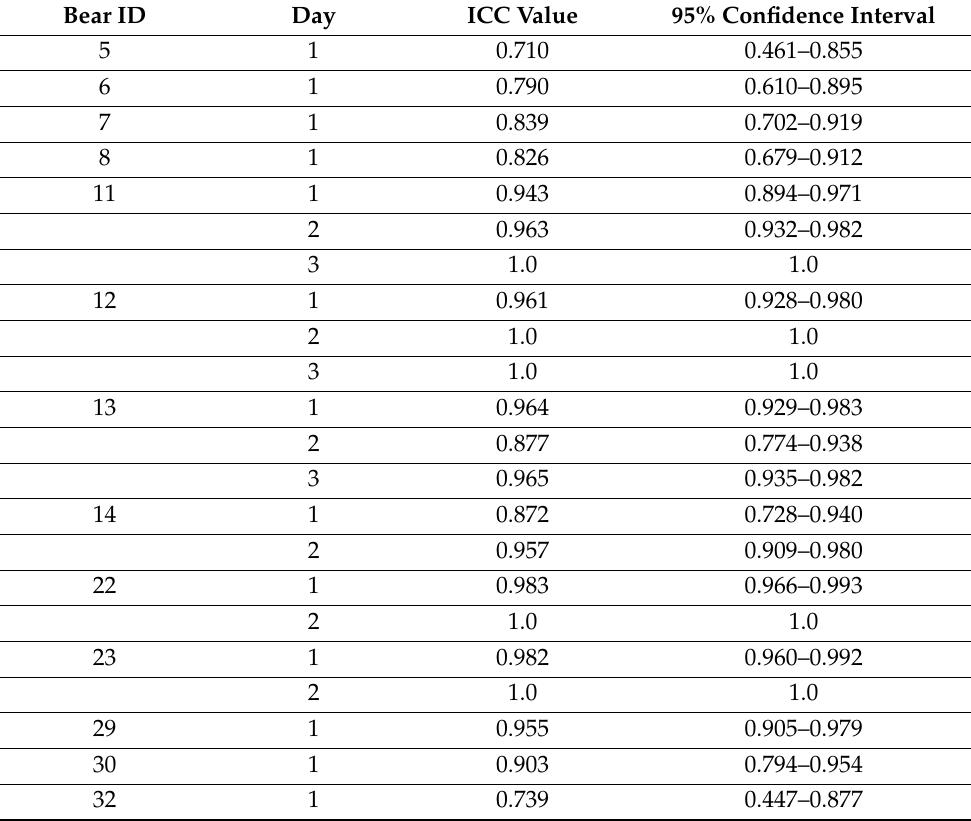
Figure 2. ICC values for all bears assessed for inter-rater reliability. The horizontal line sits at 0.75. Values above 0.75 are considered values of good reliability. In the case of bears with multiple assessments, the mean ICC score was calculated and depicted in the graph. Table 2. Level of agreement between assessors for each bear assessed for inter-rater